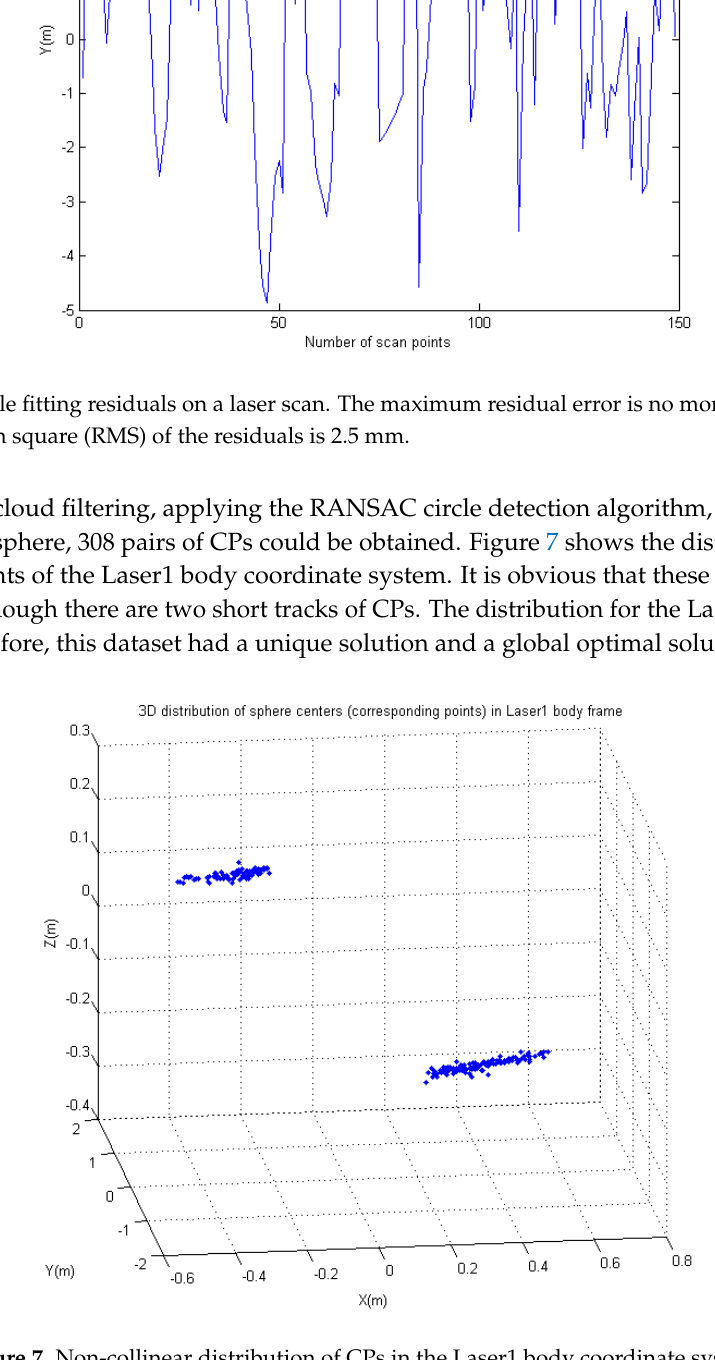
Figure 7. Non-collinear distribution of CPs in the Laser1 body coordinate system.